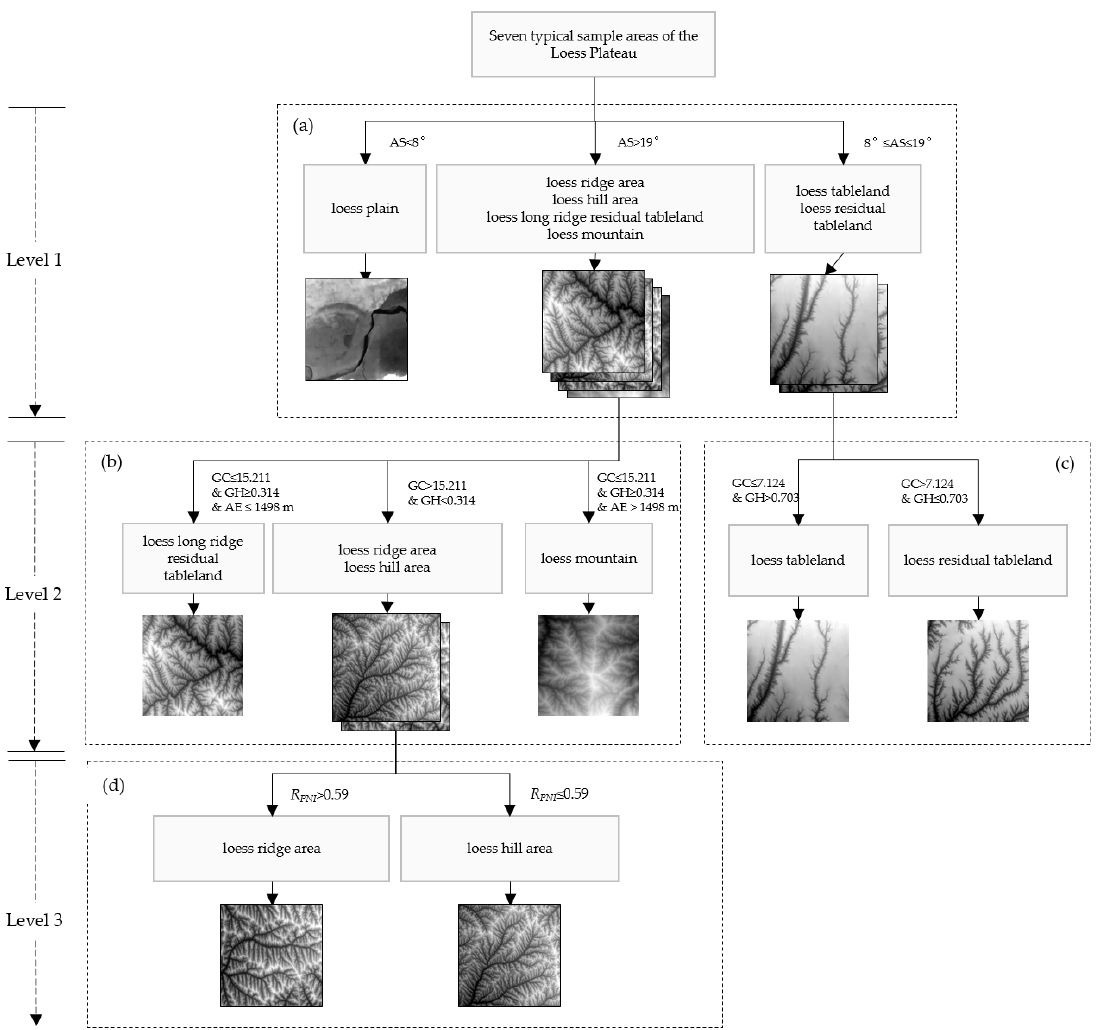
Figure 5. The flow chart of three-level recognition rules. ( a ) the first level recognition rule; ( b ) the second level recognition rule for loess gully and hilly areas; ( c ) the second level recognition rule for loess tableland; ( d ) the third level recognition rule.